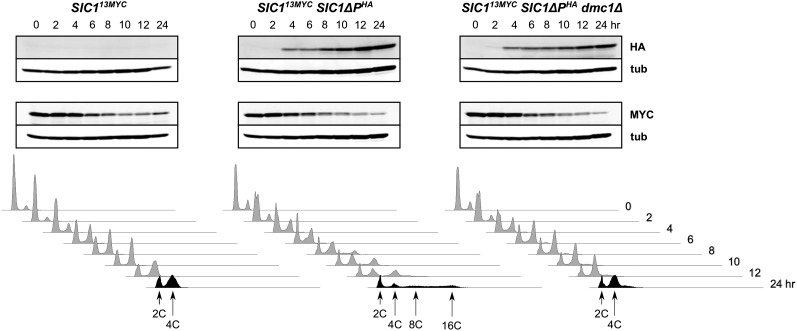
The CDK inhibitor Sic1 does not accumulate in SIC1∆PHA dmc1Δ cells. The indicated cells containing Sic113MYC were treated to enter meiosis, and then analyzed at several time points for Sic1ΔPHA (HA), Sic113MYC (MYC) and tubulin (tub) by western blotting, and for DNA content by flow cytometry.